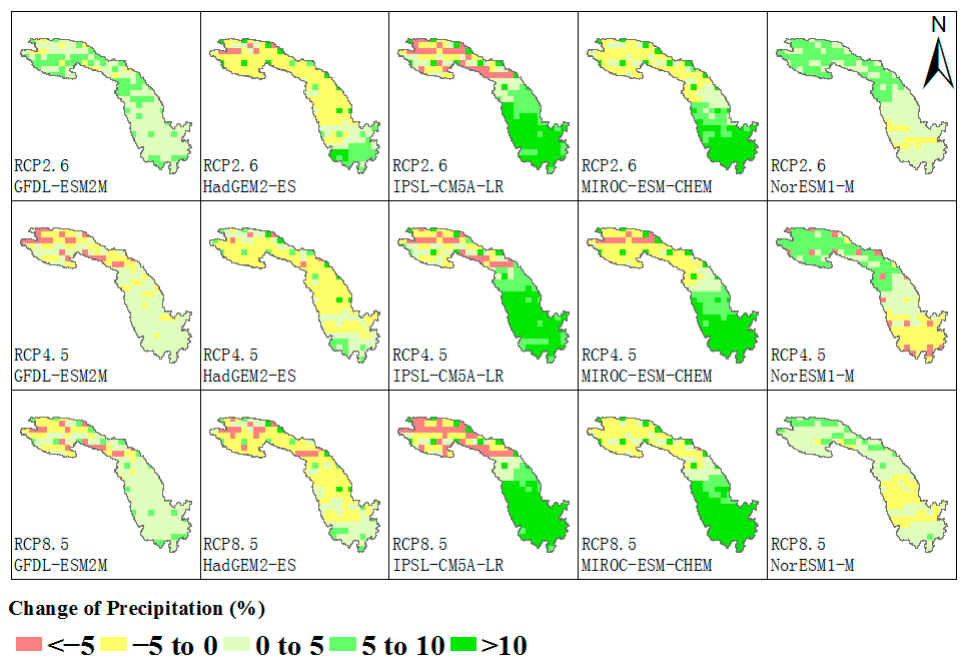
Figure 9. Change of precipitation.